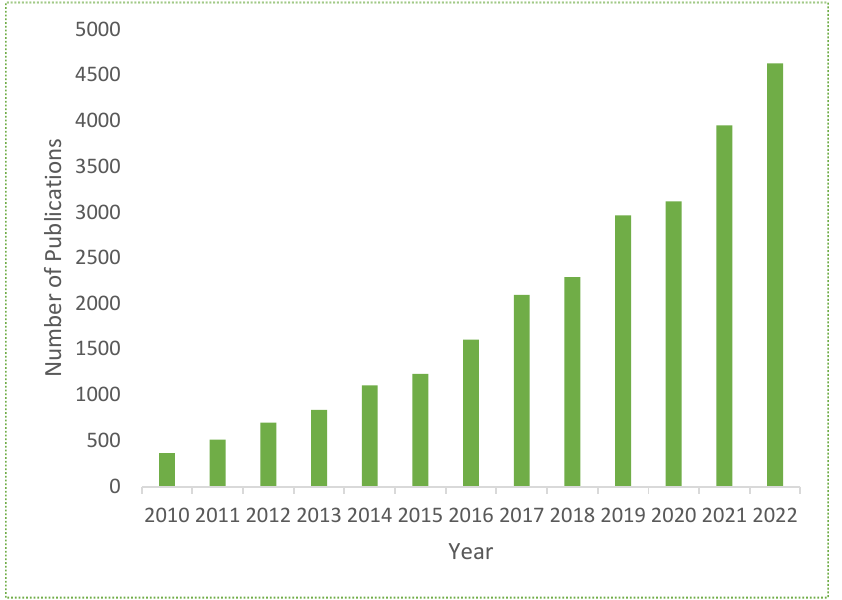
Figure 2. Published articles on nanofluids (Source: Scopus database, 2010–2022).